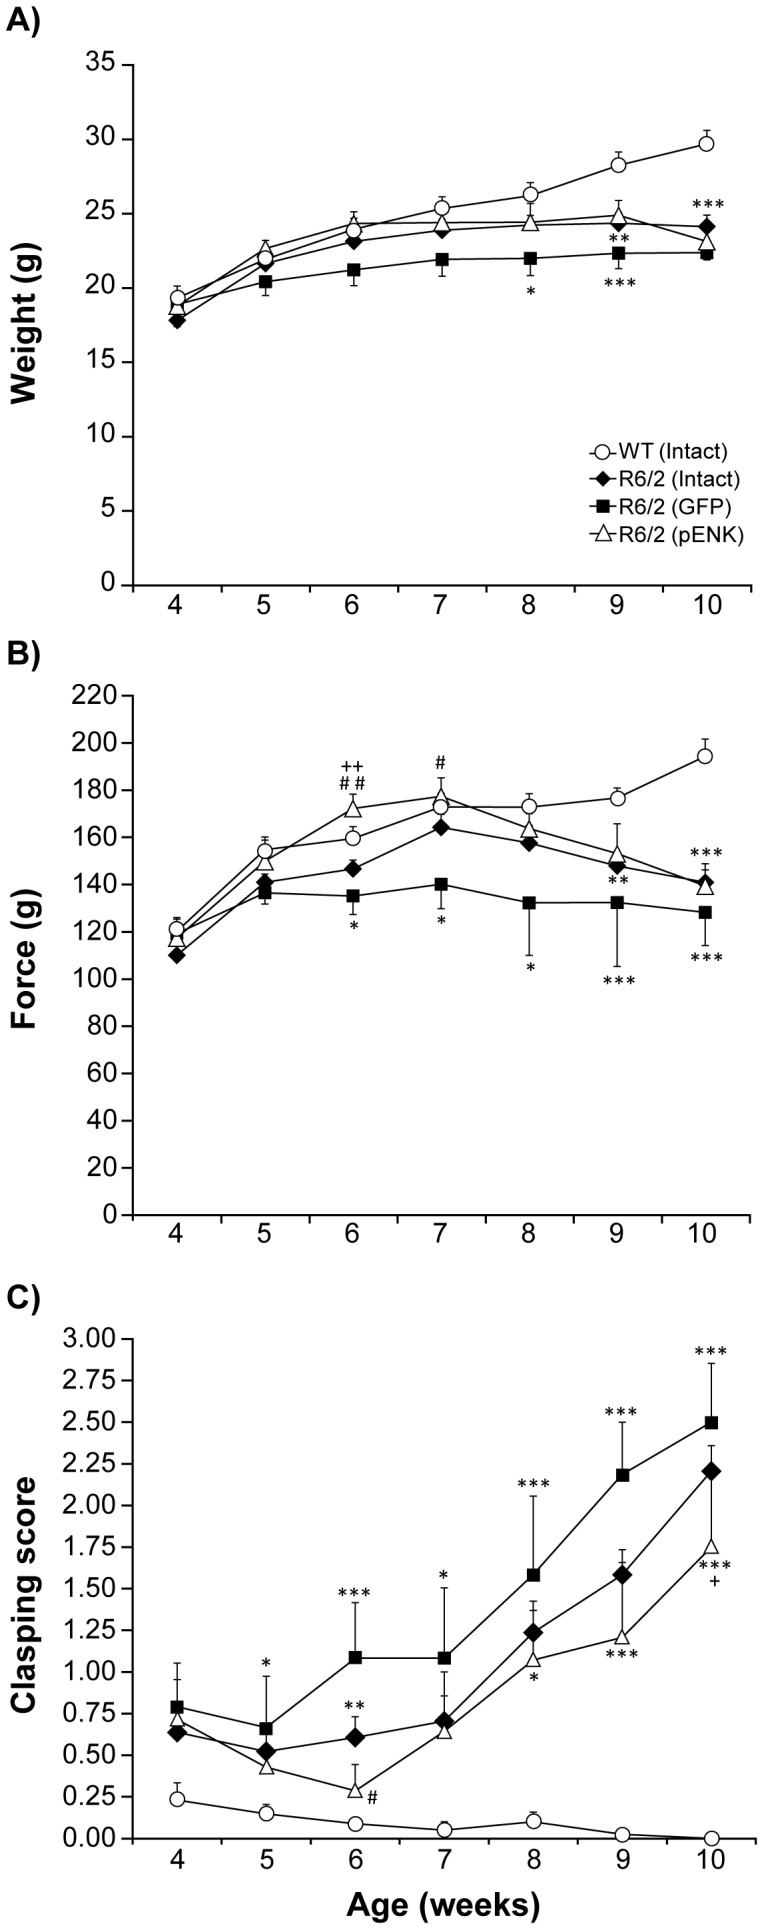
Weight, muscular force, and abnormal clasping movement of different groups of R6/2 mice and WT at different ages.At week 10, all groups of R6/2 mice displayed significantly lower weights compared to their WT counterparts. However, the failure in weight gain started sooner in R6/2 mice having received striatal rAAV2-GFP compared with pENK-injected mice. Interestingly, the decline in weight gain was delayed until week 10 in pENK- R6/2 mice compared to WT (A). The muscle force was recorded for all for- and hind- limbs as tension-peak (T-PK) to grasp grid mesh, using Grip Strength. GFP-injected R6/2 mice had an overall worse performance than other R6/2 mice. However, striatal overexpression of pENK improved the muscular force of R6/2 mice and delayed considerably the onset of decline in all limbs force (B). Higher clasping score was observed in GFP-injected R6/2 mice at different ages. However, striatal overexpression of pENK delayed the onset of this abnormal movement until week 8 compared with WT. Moreover, clasping score in pENK-injected R6/2 mice was less than GFP- injected group at 6-old-week (C). Data are presented as mean ± SEM. ** p<0.01, and *** p<0.0001 vs. WT; + p<0.01 vs. R6/2 (Intact); # p<0.01, ## p<0.01, ### p<0.005 vs. R6/2 (GFP).